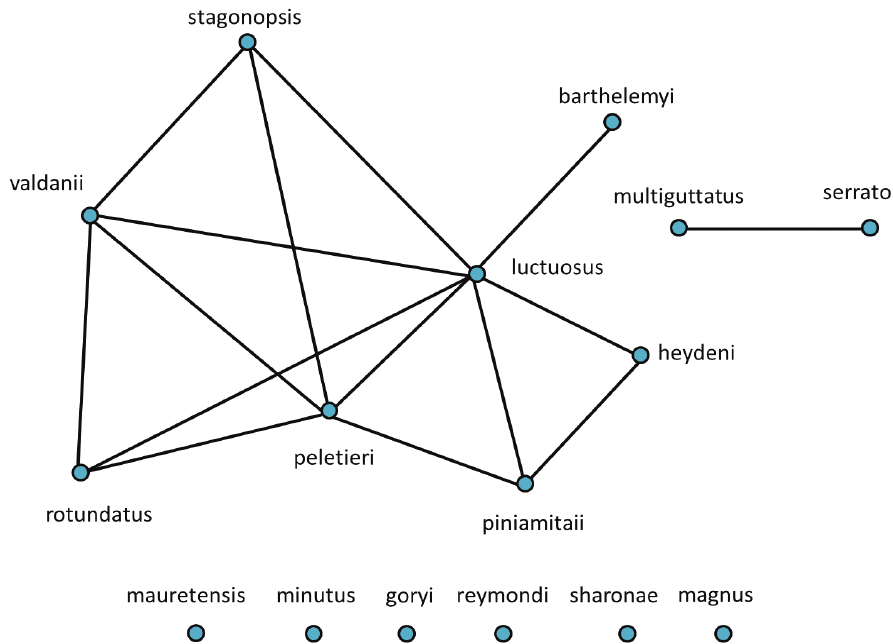
Figure 2. The ten taxa of the Graphipterus serrator group that occur sympatrically. Lines connect those taxa that co-occur sympatrically. Bottom row: the exclusively allopatrically occurring species.